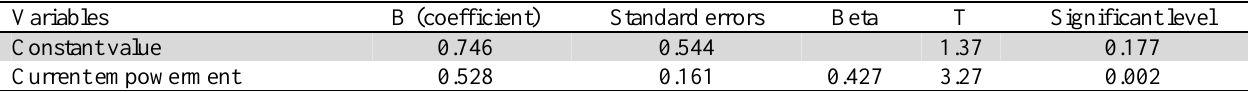
Regression model of effect of employee’s psychological empowerment on knowledge distribution Variables B (coefficient) Standard errors Beta T Significant level Constant value 0.746 0.544 1.37 0.177 Current empowerment 0.528 0.161 0.427 3.27 0.002